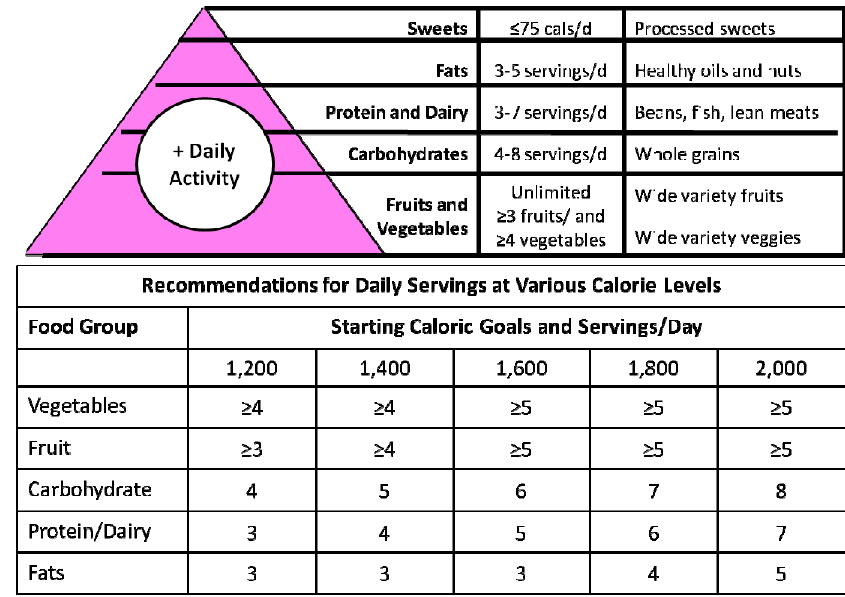
Figure 2. Food pyramid with Mediterranean diet recommendations and caloric goals [84].